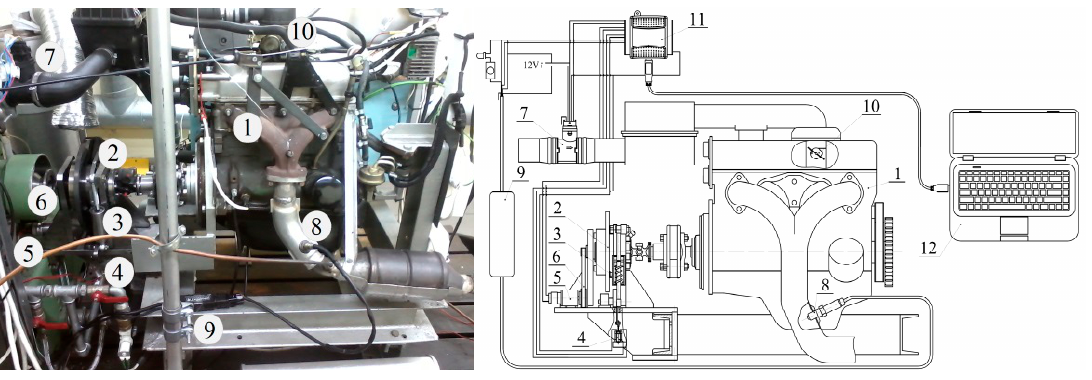
Figure 4. Test stand used for measurements in dynamic states: 1—engine, 2—friction brake,